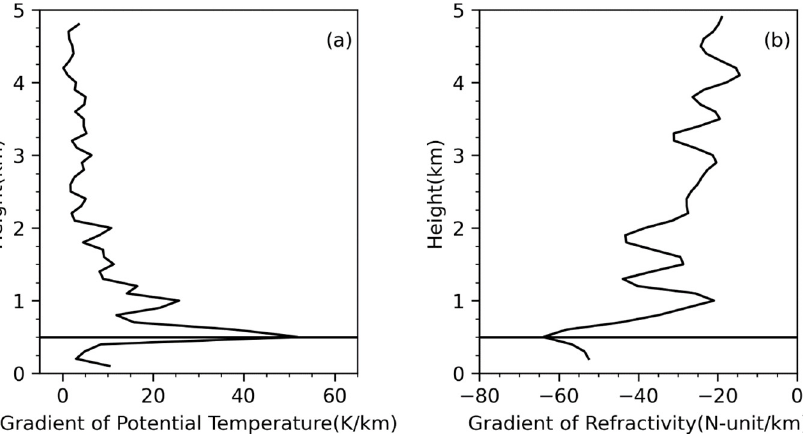
Figure 1. The radiosonde/RO co-location 1 gradient profiles of ( a ) potential temperature and ( b ) refractivity. The black horizontal lines show the PBLHs. The radiosonde event occurred at 2300UTC on 30 January 2010, located at (156.8°W, 71.3°N); the radio occultation event (RO1) occurred at 2326UTC on 30 January 2010, located at (157.0°W, 71.6°N).